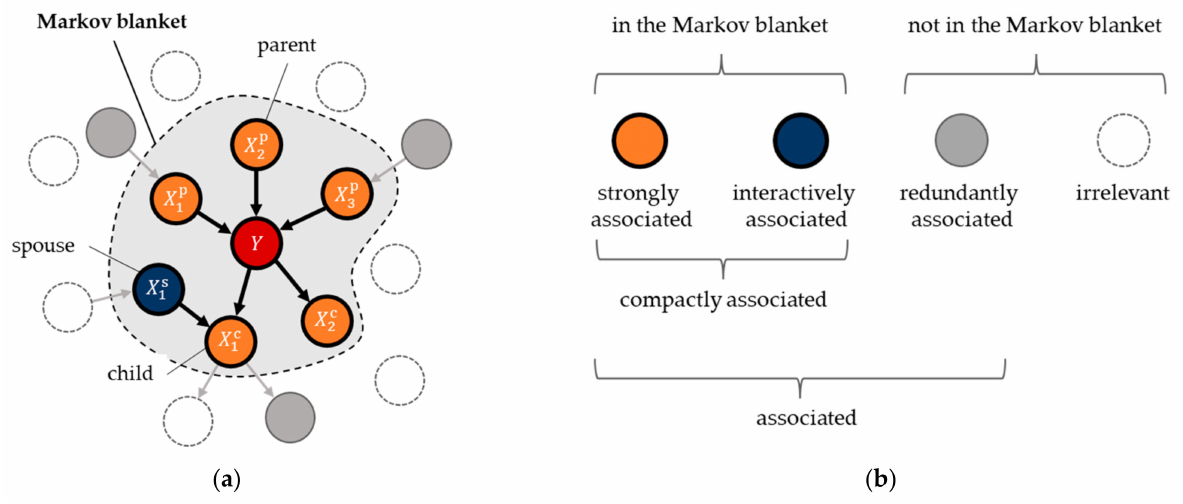
Figure 3. ( a ) Schematic of Bayesian network; ( b ) data association relations in ( a